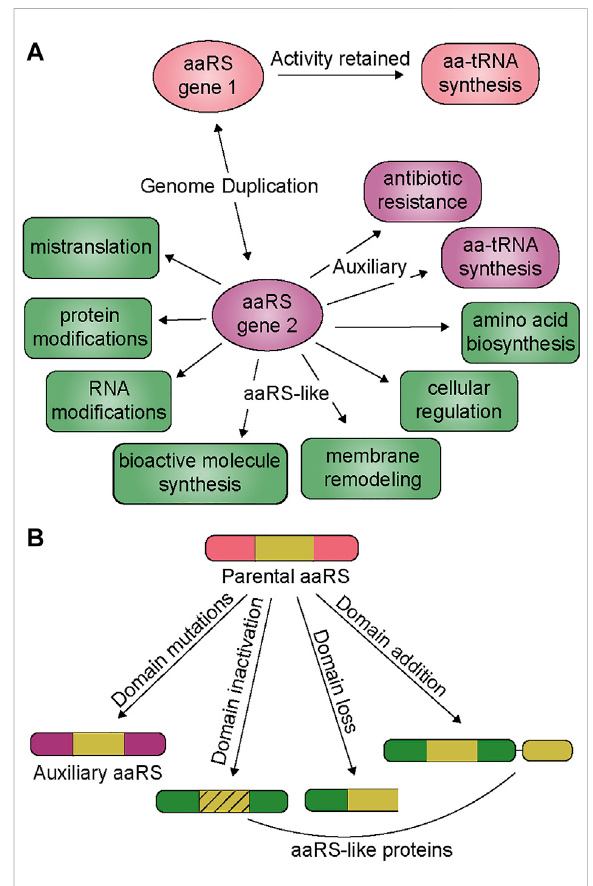
FIGURE 1 (A) Duplication and divergence of aaRS genes. Genomic duplication generates a new aaRS gene (aaRS gene 2) while preservingtheparentalcopy(aaRSgene 1)whichisresponsiblefor the housekeeping tRNA aminoacylation activity. The second copy (aaRS gene 2) either develops new characteristics under speci fi c selection pressures (auxiliary function, purple rounded squares) or a combination of genetic drift and selection can produce an aaRS-like protein with new activity (green boxes) (B) From the parental aaRS protein, mutations and protein architecture can change, leading to non-canonical functions. Domain mutations generally give rise to auxiliary functions while aaRS-like proteins are found with inactive domains, or the loss or addition of